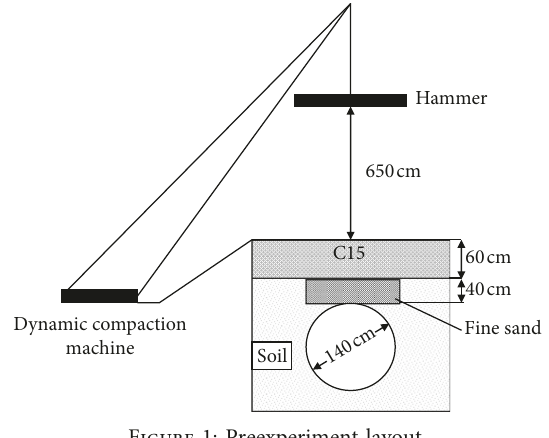
Figure 1: Preexperiment layout. Table 1: Mass and size of drop